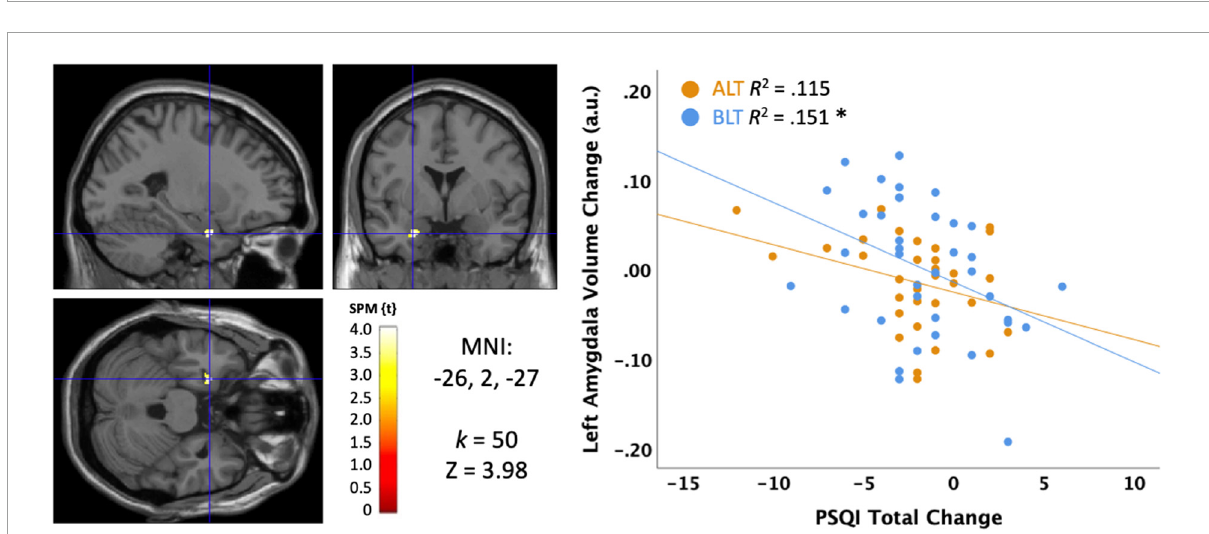
FIGURE7 Correlation between sleep quality change on the Pittsburgh Sleep Quality Index (PSQI) and the change in left amygdala volume after 6 weeks of treatment with blue light treatment (BLT) or amber light treatment (ALT). The left panel shows the location of the significant cluster in the amygdala for the entire sample, p < 0.05 FWE cluster corrected. The right panel shows the scatterplot for the BLT and ALT samples separately. MNI, Montreal Neurologic Institute stereotaxic coordinates. * p <